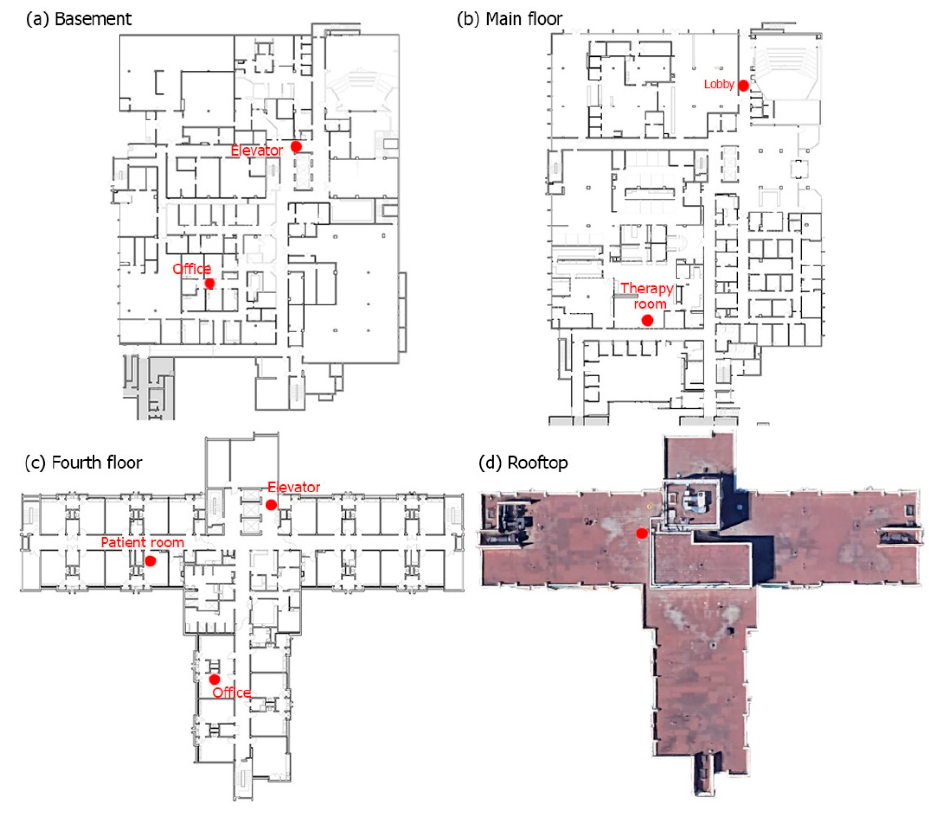
Figure 1. Floor plan of the facility with locations of low-cost sensors (red dots).